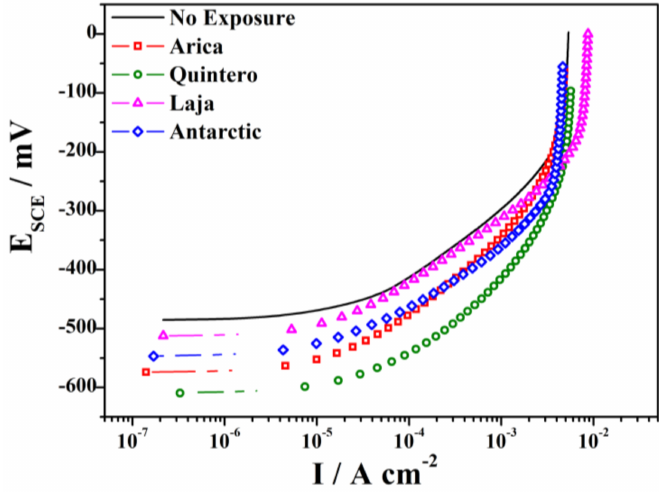
Figure 8. Anodic curves of SAE 1020 steel exposed for 36 months in different areas of